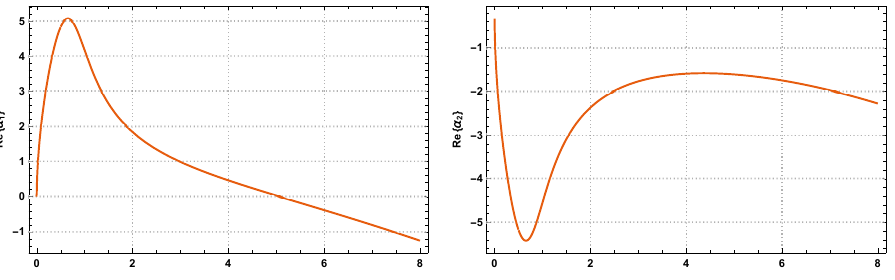
Figure 3. Plots of (cid:60) ( α 1 ) and (cid:60) ( α 2 ) versus wavenumber k for the plug-flow model with h 0 = 2, u 0 = f ( h 0 ) , a = 100, b = 2 and c = 0.05. While (cid:60) ( α 2 ) stays negative for all k , α 1 has a positive